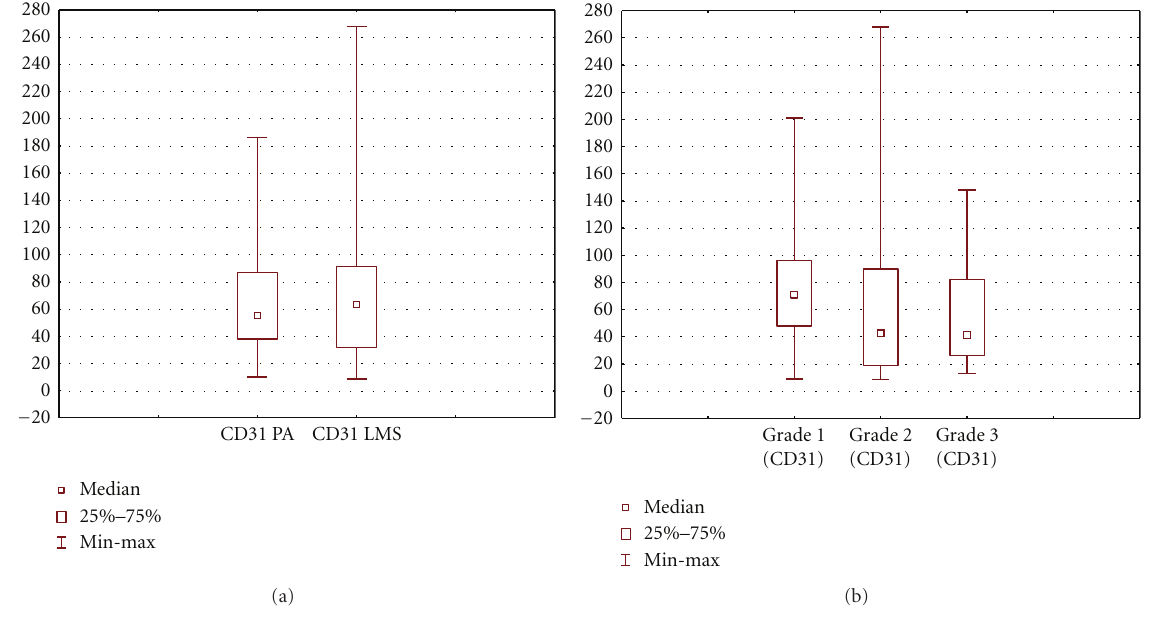
Figure 5: MVD in the PA and LMS: (a) total and (b) at di ff erent grades of malignancy of LMS. Data are presented as median/quartile/range.